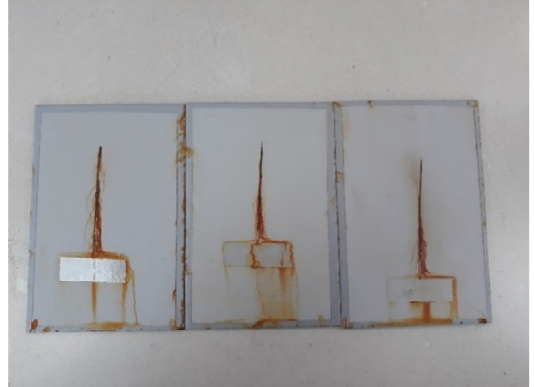
Figure 5. Test specimens inside the salt chamber workspace.